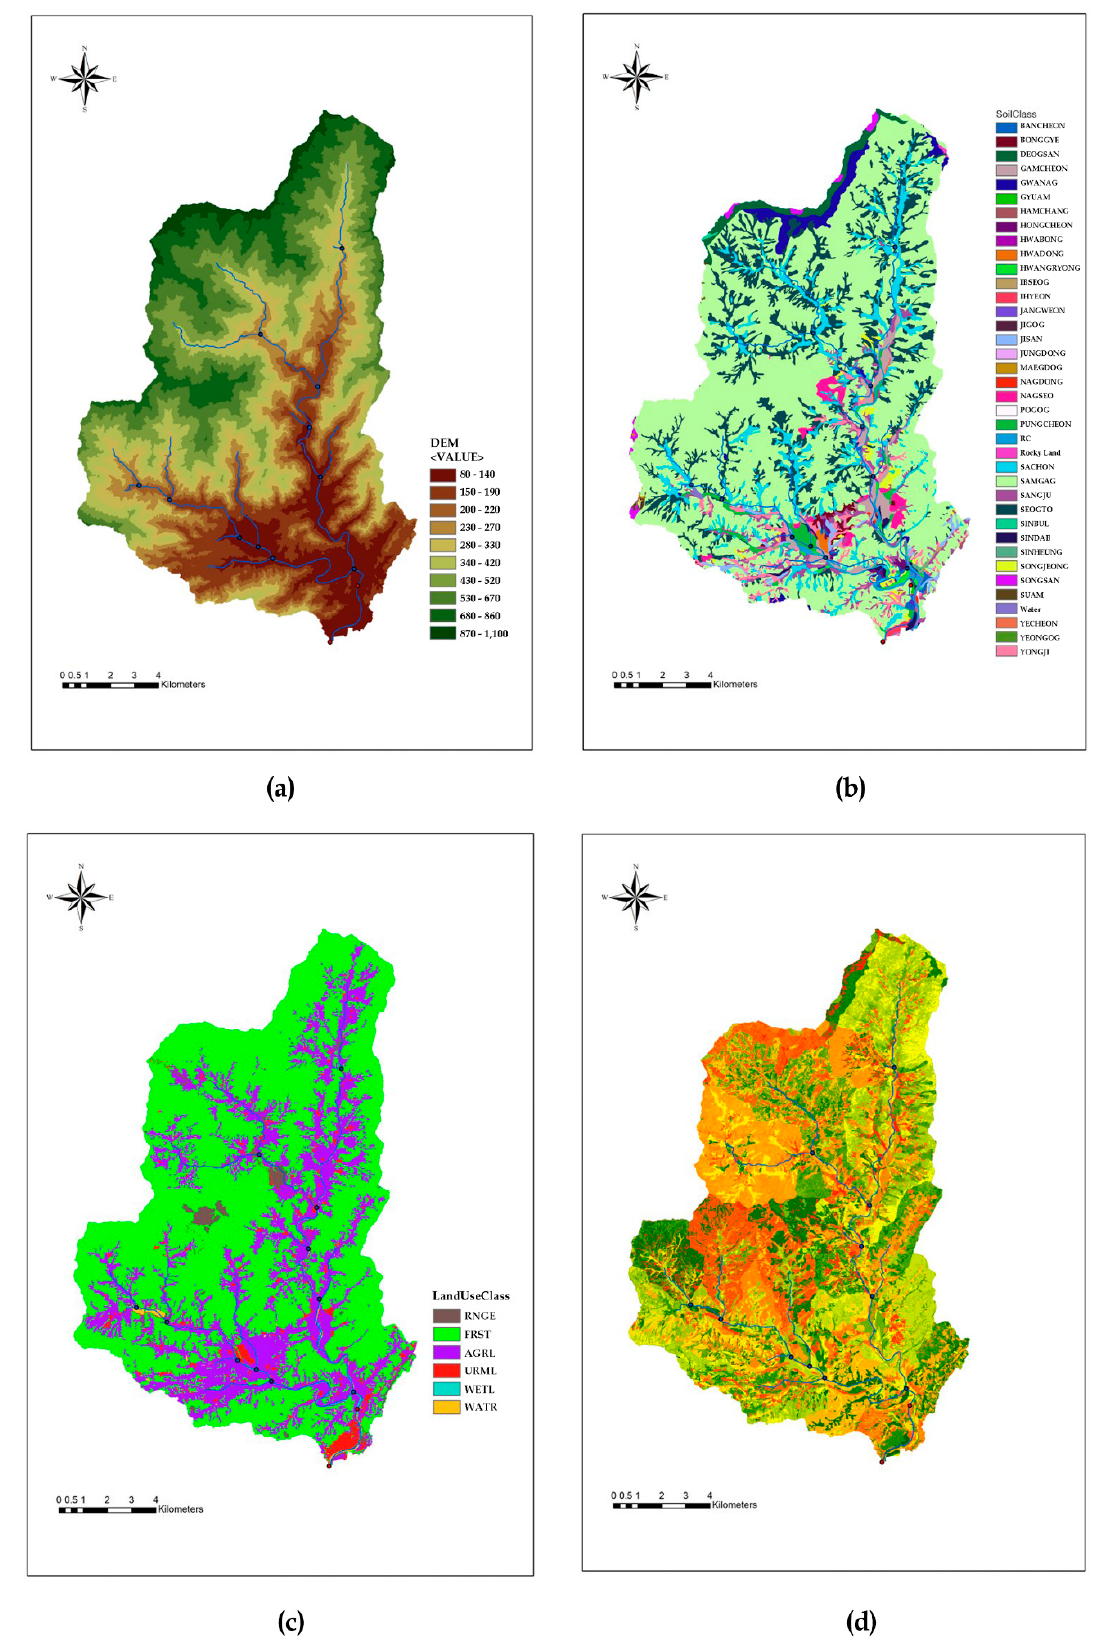
Figure 5. Soil and Water Assessment Tool model topographical data: ( a ) digital elevation model (DEM); ( b ) soil map; ( c ) land use map; ( d ) hydrologic response unit ( n = 2274).